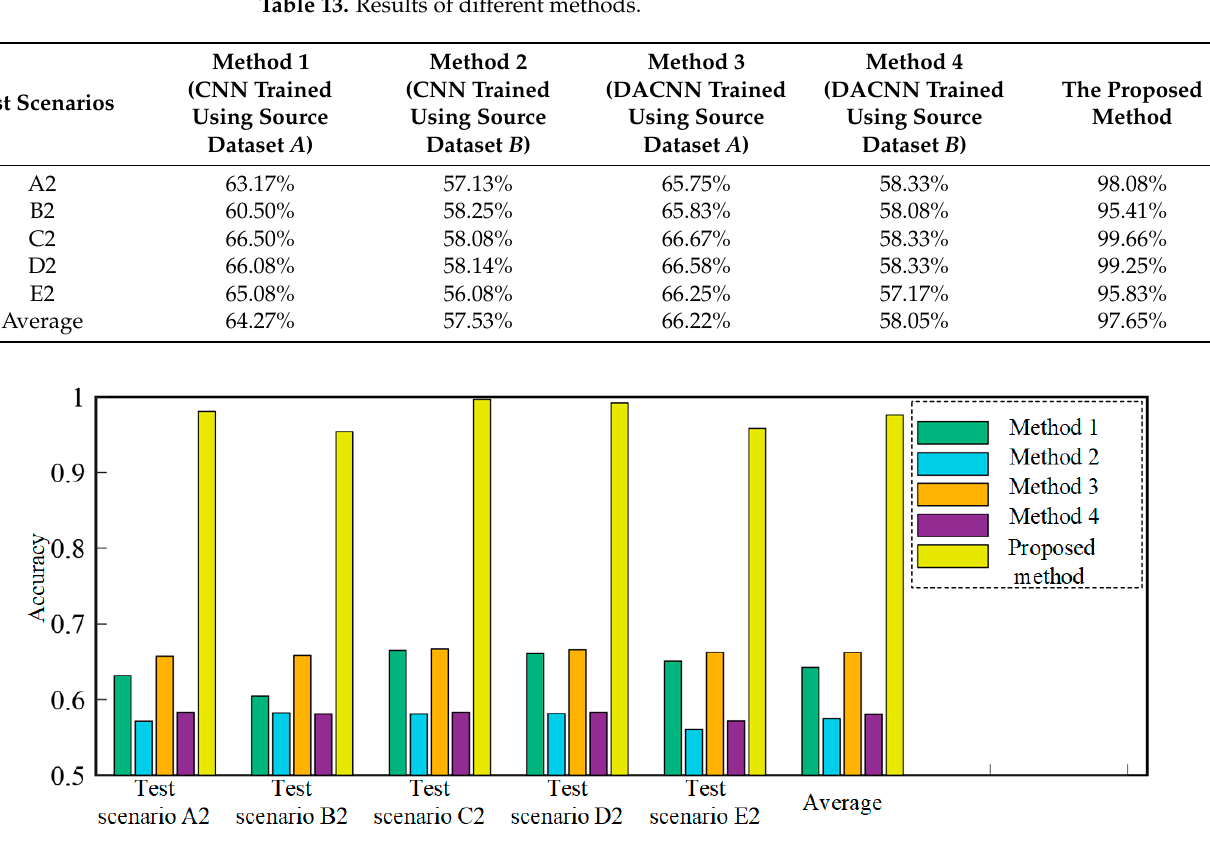
Figure 14. The results diagram for different methods.